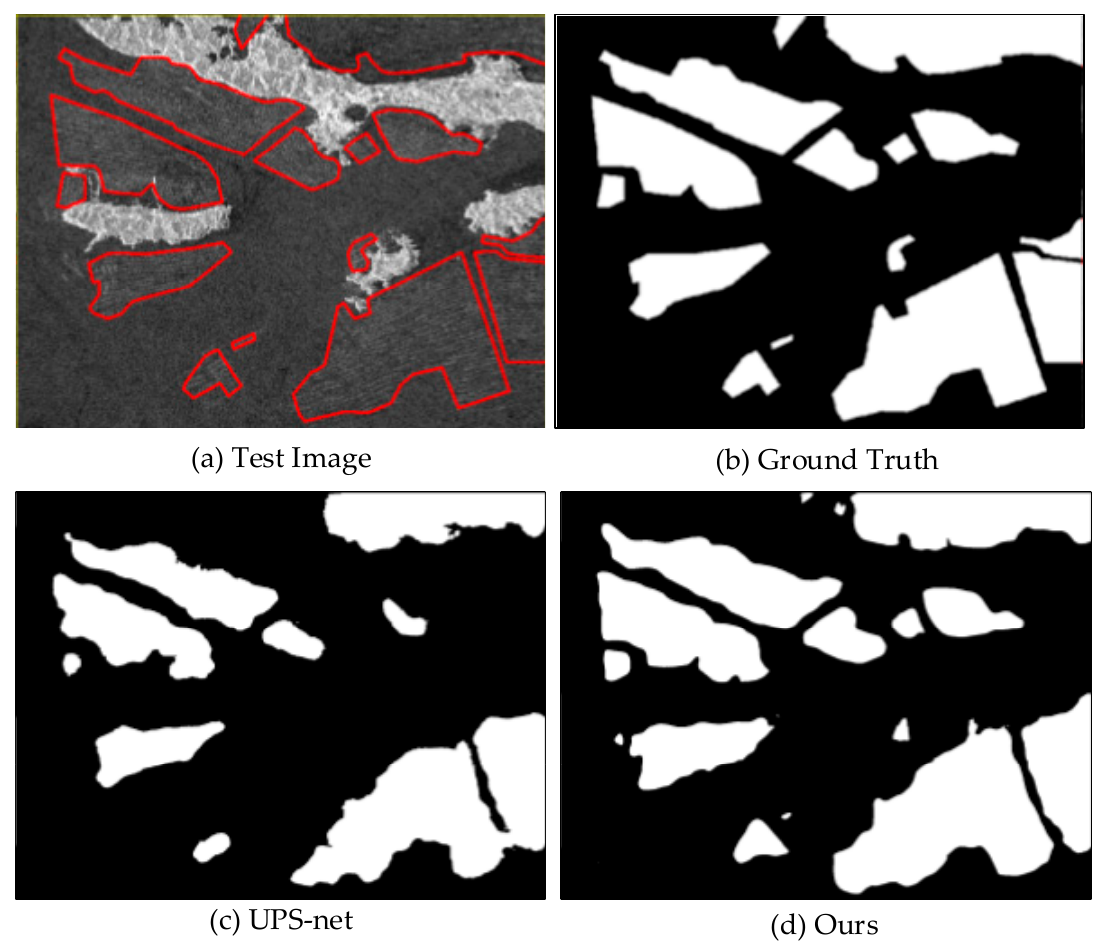
Figure 16. Results of the comparison experiment for a subset of the study area. ( a ) Test image. ( b ) Ground truth. ( c ) The results obtained by UPS-net. ( d ) The results obtained by the proposed method. Table 4. Precision, recall, F1, and IOU scores on the test data of the comparative experiment. Method